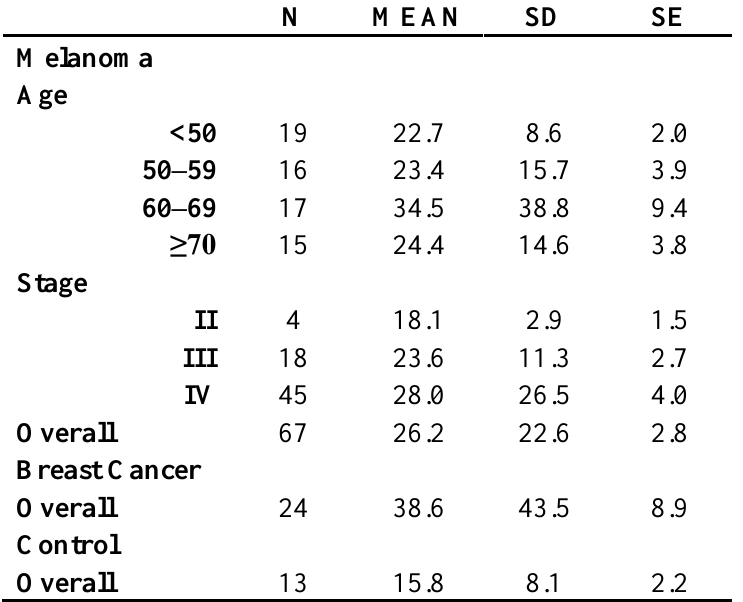
Table 2. Comparison of serum Cathepsin B levels (ng/mL) by